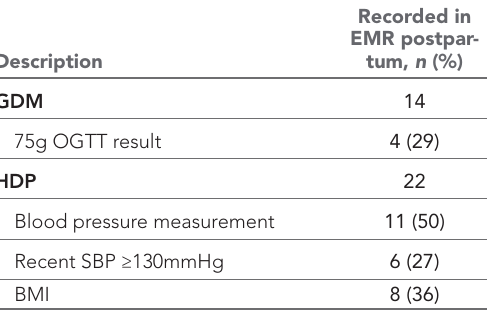
Table 1 Postpartum follow- up of essential risk factors documented in the EMR